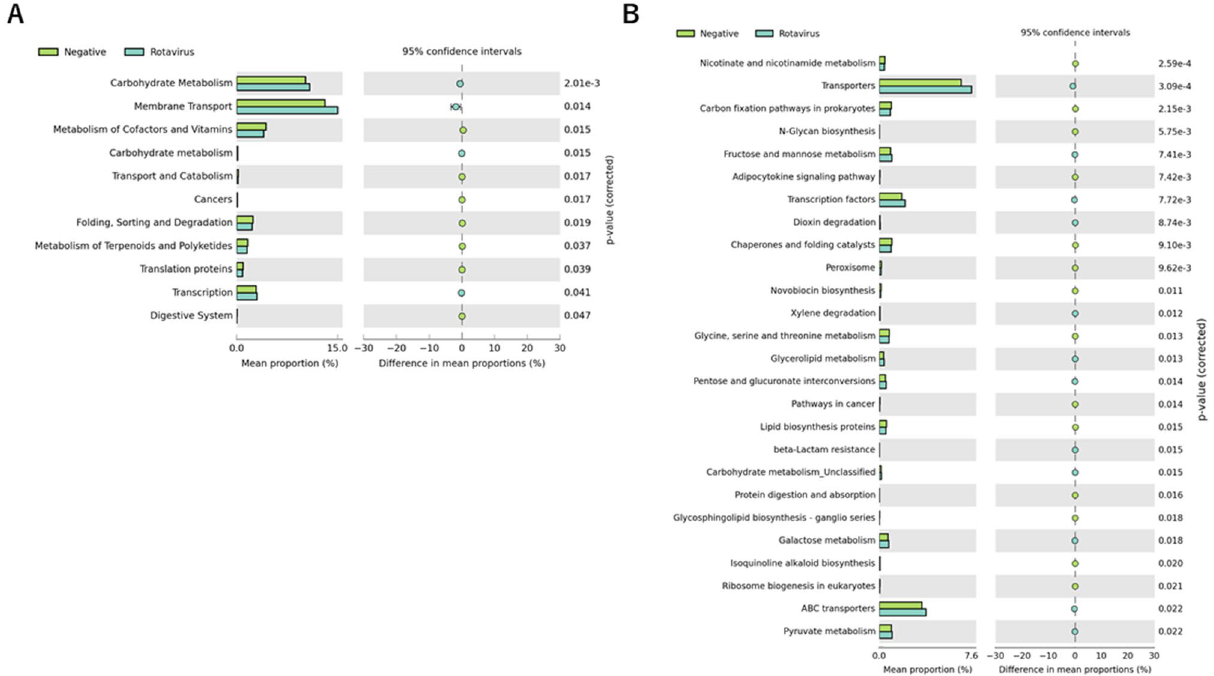
Figure 6. Distribution of Kyoto Encyclopedia of Genes and Genomes (KEGG) functional categories. Comparison between healthy controls and rotavirus-positive patients with diarrhea on levels 2 ( A ) and 3 ( B ) of KEGG. Functional contributions of the gut microbiota were analyzed using PICRUSt